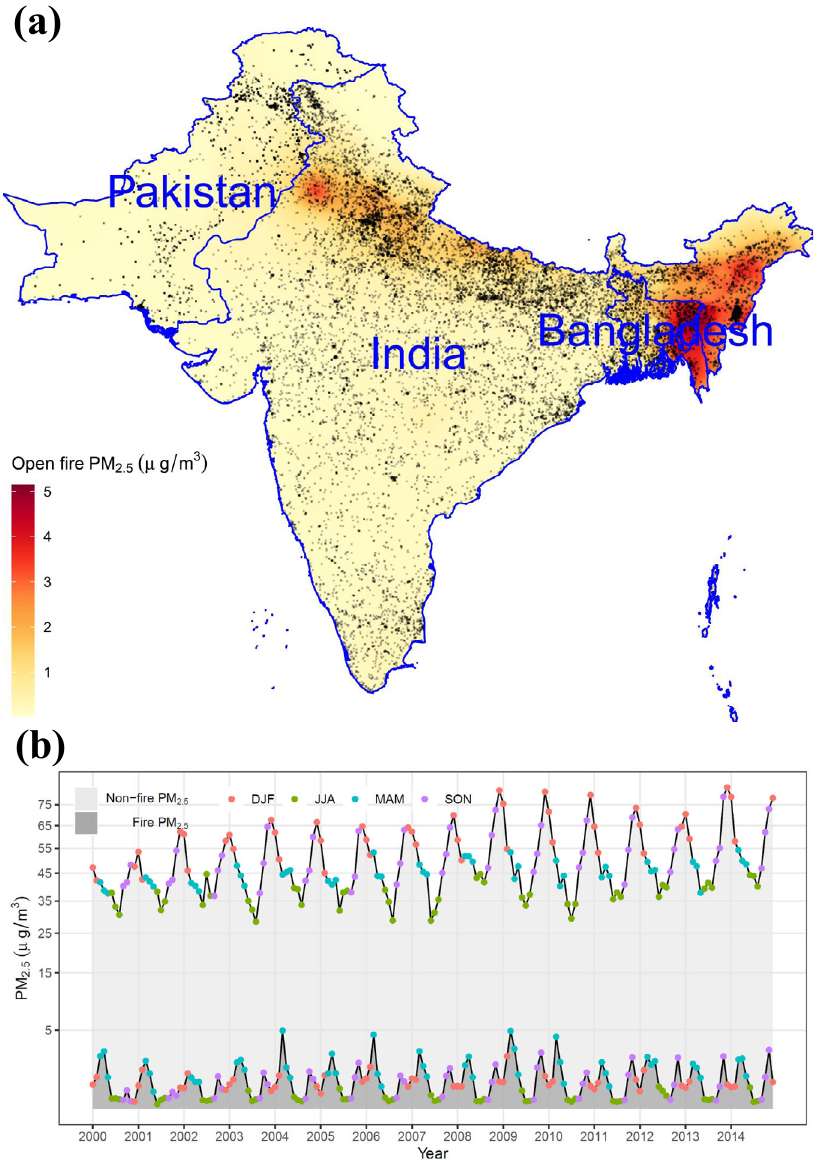
Fig. 1 Spatial and temporal variations in the concentrations of PM 2.5 attributable to open fi re. Panel a presents the mean concentration of open fi re PM 2.5 during 2000 – 2014 with locations of surveyed samples (black dots). Panel b presents the population-weighted means of open fi re or non- fi re PM 2.5 by month. The map in Panel a is generated by the corresponding author (T.X.) using the data from Natural Earth (https://www.naturalearthdata.com/). PM 2.5 : particulate matter with a diameter of less than 2.5 µ m; DJF: December – January – February; MAM: March – April – May; JJA: June – July – August; SON: September – October – November. Table 1 Estimated associations between pregnancy loss and three indicators of open fi re exposure. Adjusted for covariates * PM 2.5 mutually adjusted † , ‡ Odds ratio per increment